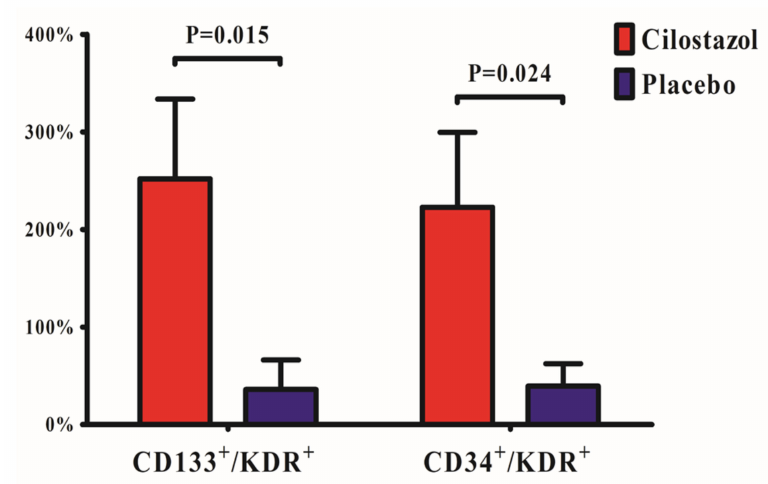
Figure 3. Relative changes of endothelial progenitor cell counts between baseline and 30 days. CilostazoltreatmentwasassociatedwithsignificantrelativechangesofCD133 + / KDR + andCD34 + / KDR + endothelial progenitor cells compared with placebo. Data are expressed as the mean percentage of cells positive for each marker ± SEM. Table 3. Circulating EPC levels and hemostatic measurements at baseline and follow-up. Baseline Follow-Up Parameters Cilostazol Placebo p Value Cilostazol Placebo p Value Circulating EPC levels